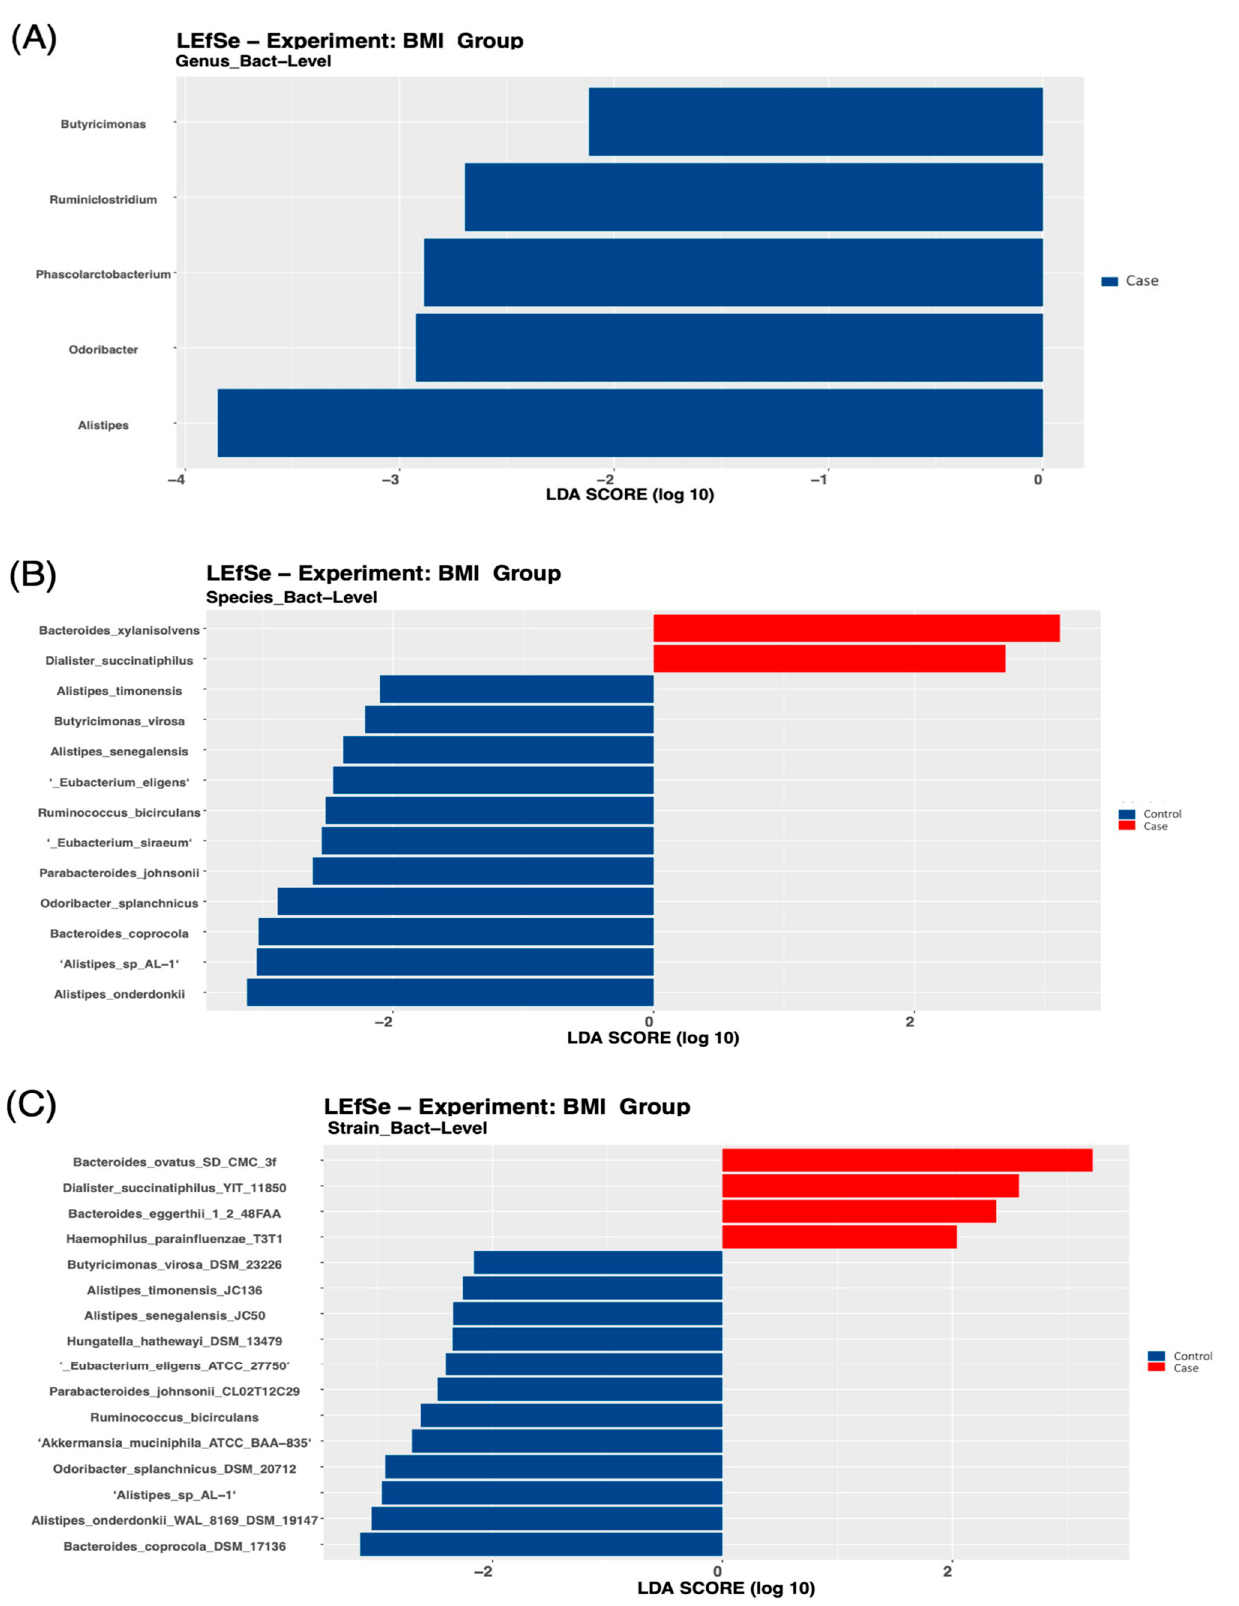
Figure 4. Linear Discriminant Analysis Effect Size (LEfSe) of the microbial taxa between the group with obesity (case group) and the group with normal BMI (control group): ( A ) genus level, ( B ) species level, and ( C ) strain level.